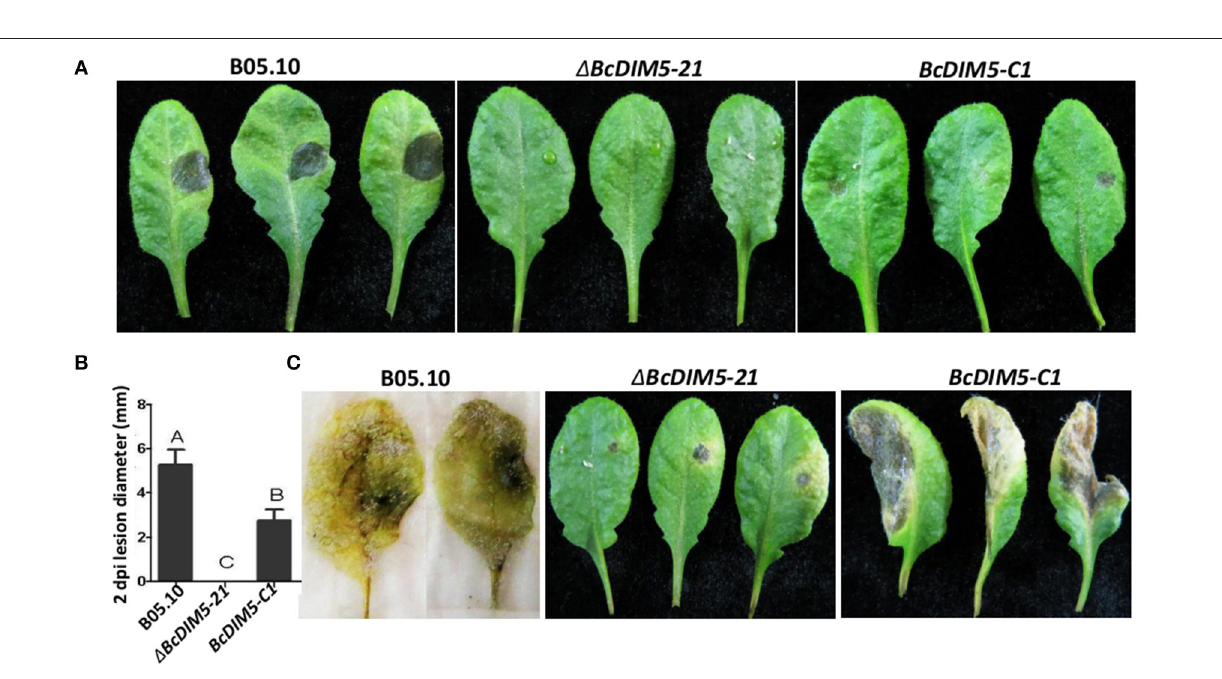
FIGURE 3 | Pathogenicity assays of the ∆ BcDIM5-21 strain of B. cinerea on detached Arabidopsis leaves. (A) Four-week-old Arabidopsis detached leaves were inoculated by 5 µ L conidia (concentration is 5 × 10 5 spores/mL) of wild type B05.10 (left), BcDIM5 knockout ∆ BcDIM5-21 strain (middle), BcDIM5 complemented BcDIM5-C1 strain (right). The representative symptoms were photographed at 2dpi. The experiment was repeated three times. (B) Comparison of the lesion diameters of the wild-type B05.10 strain, BcDIM5 knockout, and complemented strains. (C) Four-week-old Arabidopsis detached leaves were inoculated by 5µL conidia (concentration is 5 × 10 5 spores/mL) of wild-type B05.10 strain (left), BcDIM5 knockout ∆ BcDIM5-21 strain (middle), BcDIM5 complemented BcDIM5-C1 strain (right). The representative symptoms were photographed at 5dpi after